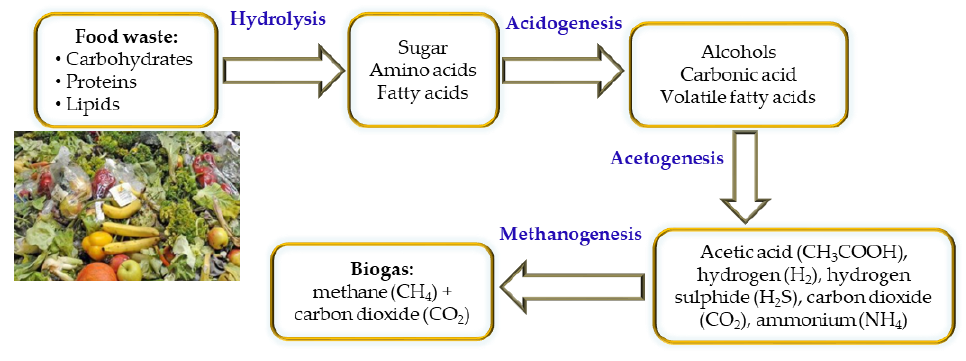
Figure 7. AD stages (modified after [115,116]).